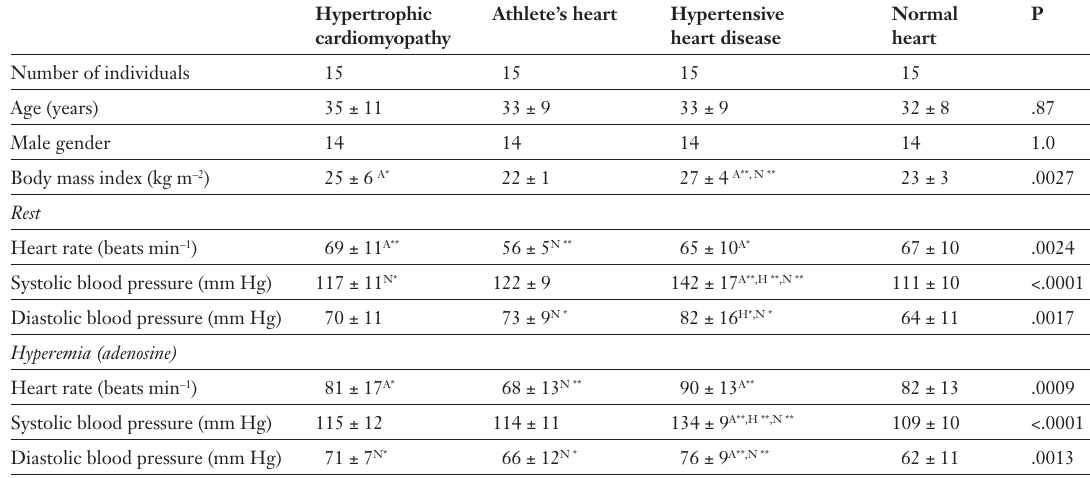
Participant character- istics and clinical